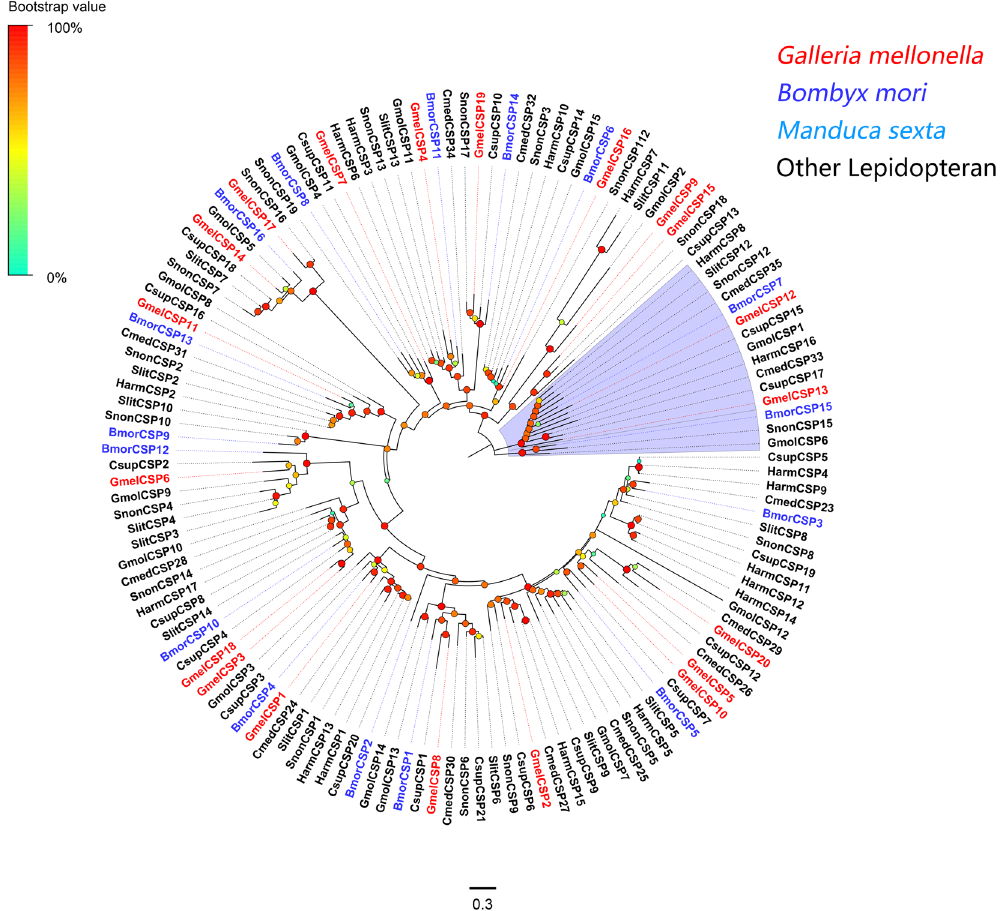
Figure 5. Maximum-likelihood tree of CSPs. The distance tree was rooted by the conservative CSP gene clade (GmelCSP12 and GmelCSP13) (lilac). Species abbreviations: Gmel, Galleria mellonella ; Bmor, Bombyx mori ; Cmed, Cnaphalocrocis medinalis ; Cfum, Choristoneura fumiferana ; Csup, Chilo suppressalis ; Gmol, Grapholita molesta ; Slit, Spodoptera litura ; Msex, Manduca sexta ; Snon, Sesamia nonagrioides ; Harm, Helicoverpa armigera ; Hvir, Heliothis virescens . Node support (circles at the branch nodes) was estimated using an approximate likelihood ratio test based on the scale indicated at the top left. Bars indicate branch lengths in proportion to amino acid substitutions per